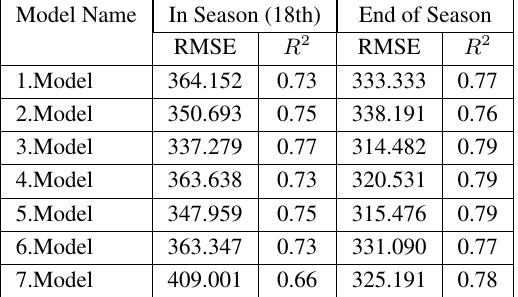
Table 7. 5-fold cross validation results of CNN-LSTM